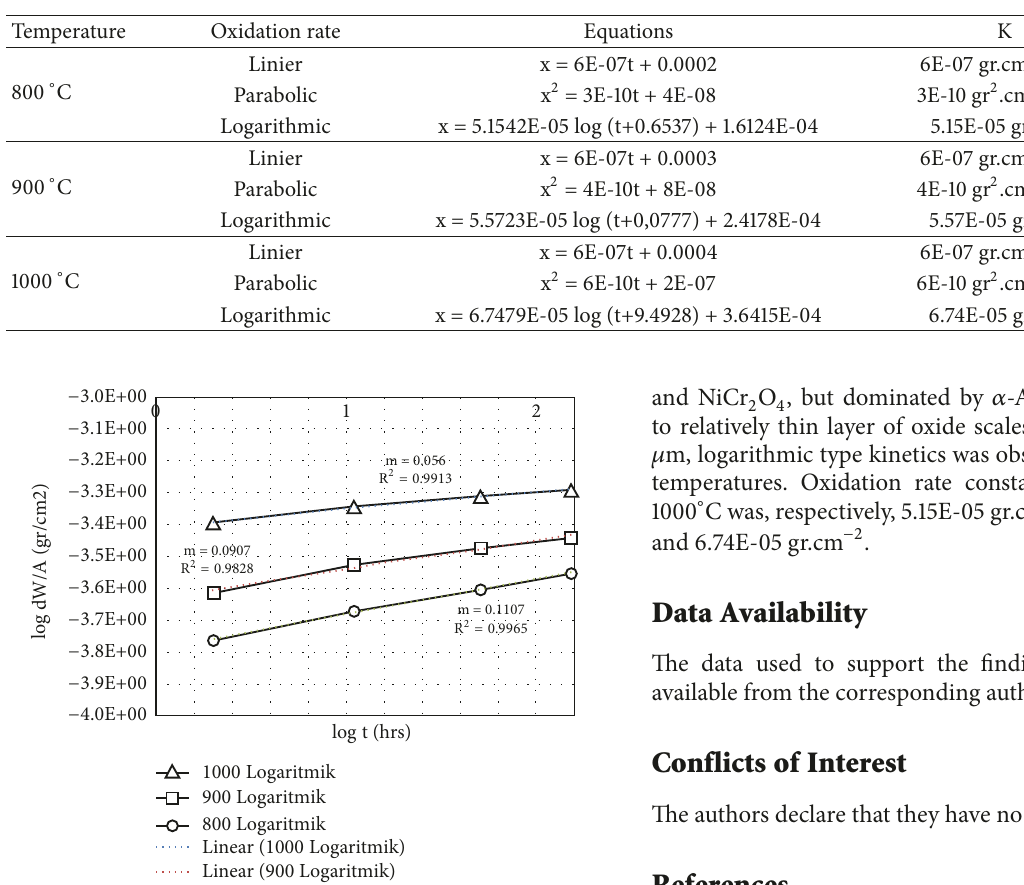
Table 2: Oxidation rate equations and rate constants of samples at different temperatures.